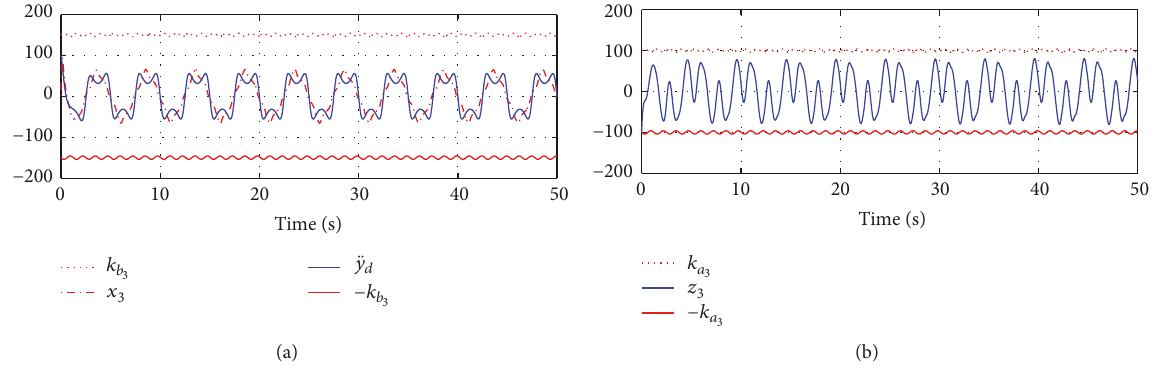
Figure 3: (a) Trajectories of 𝑥 3 (dashed) and ̈𝑦 𝑑 (solid); (b) the trajectory of tracking error 𝑧 3 .